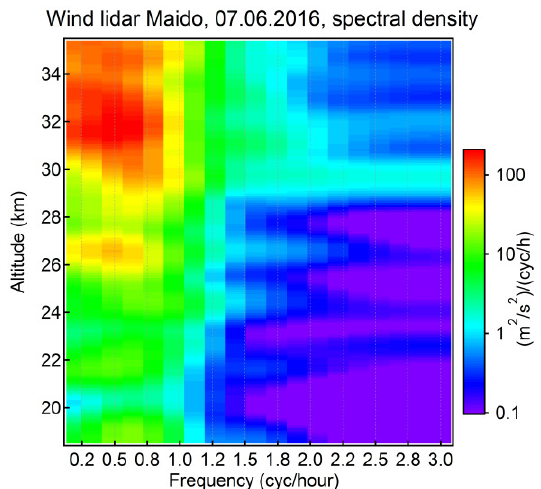
Figure 4. Power spectrum of stratospheric gravity wave frequency as a function of height derived from Maido wind lidar acquisition on